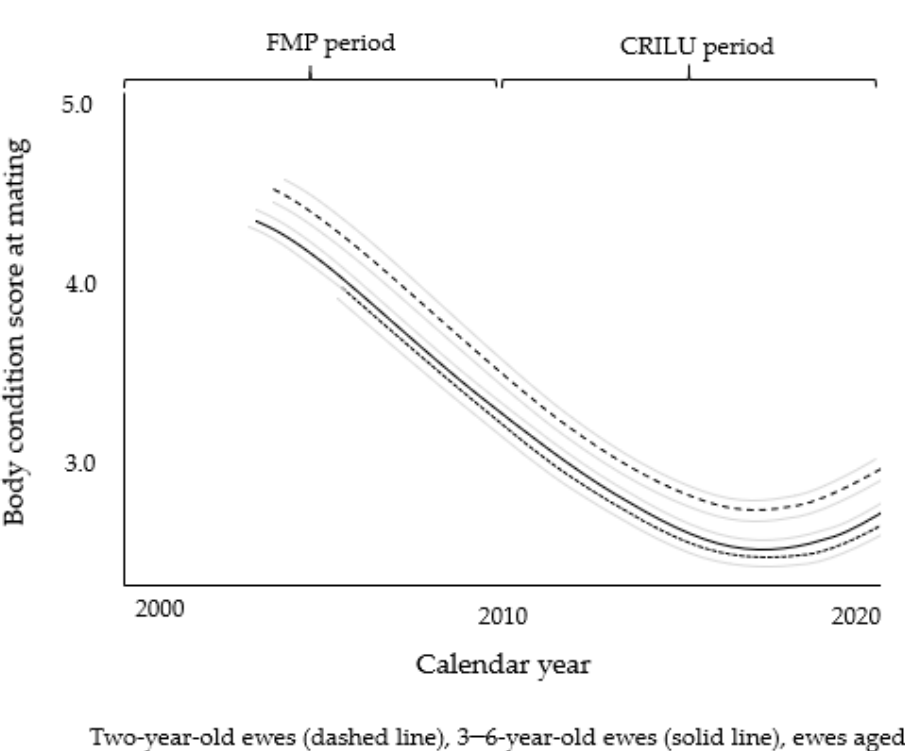
Figure 4. Two-year-old ewes, 3–6-year-old ewes, and ewes aged seven or older phenotype trends using a third-degree polynomial regression model for the average BCS at mating across calendar years (2002–2020). Table 5. Least square means (LSMs) and standard errors of the mean (SEMs) of accumulative total wool production (TWool, kg), total number of lambs weaned (TLW, n ), and total lamb live weight at weaning (TWW, kg) by lambing opportunity